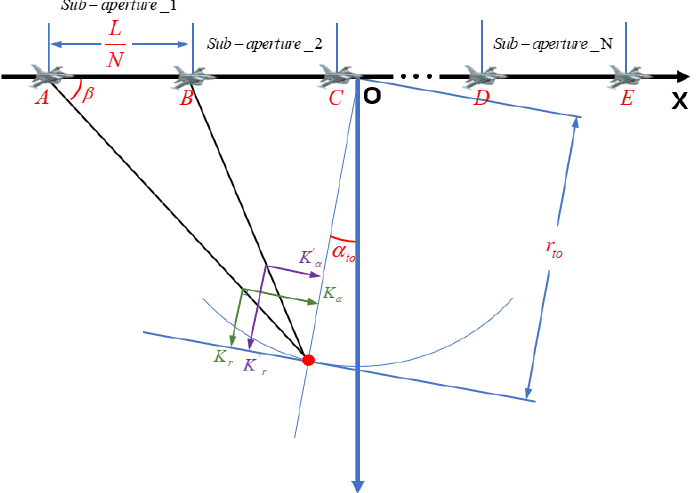
Figure 3. Rules for coordinate system establishment in WFBP